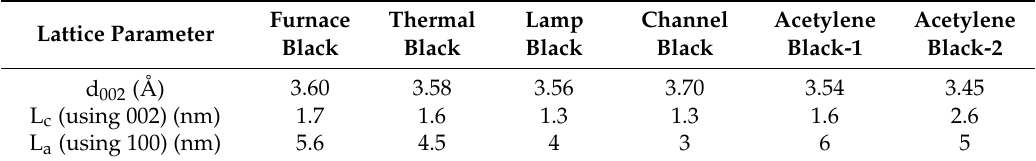
Table 1. Lattice parameters from X-ray